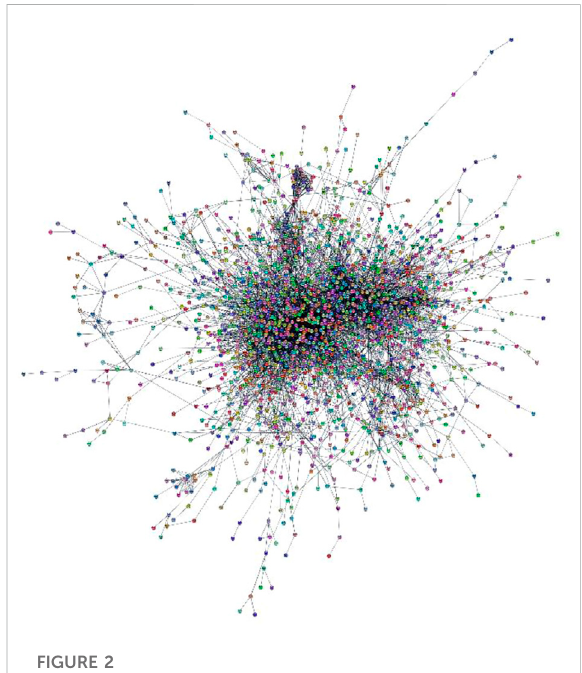
FIGURE 2 MiRNome_MC network. The fi gure shows the MiRNome Main Component (MiRNome_MC). The network was created with Cytoscape 3.7.2.